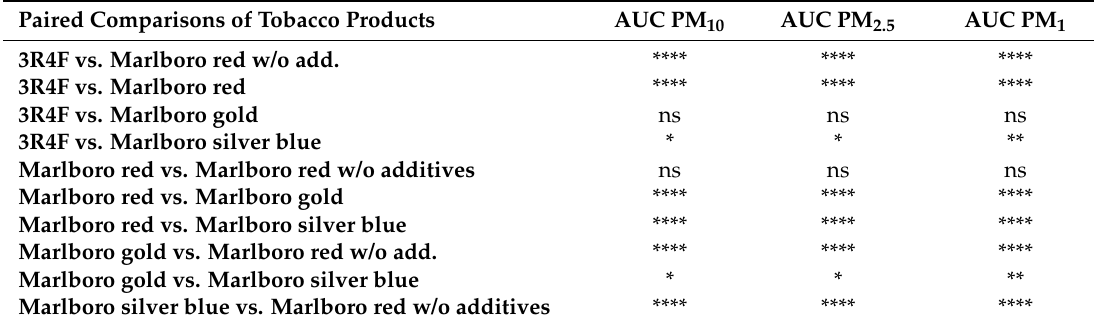
Table 3. Significance level of statistical Tukey’s multiple comparisons test of AUC (PM 10 , PM 2.5 and